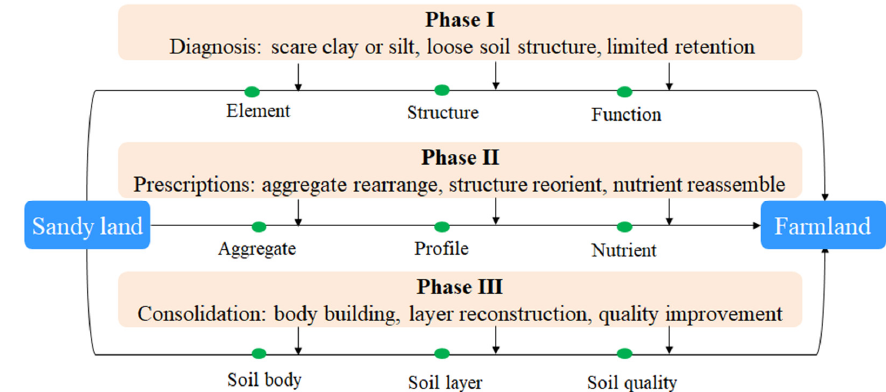
Figure 1. Theoretical framework of sandy land diagnosis and structural consolidation.